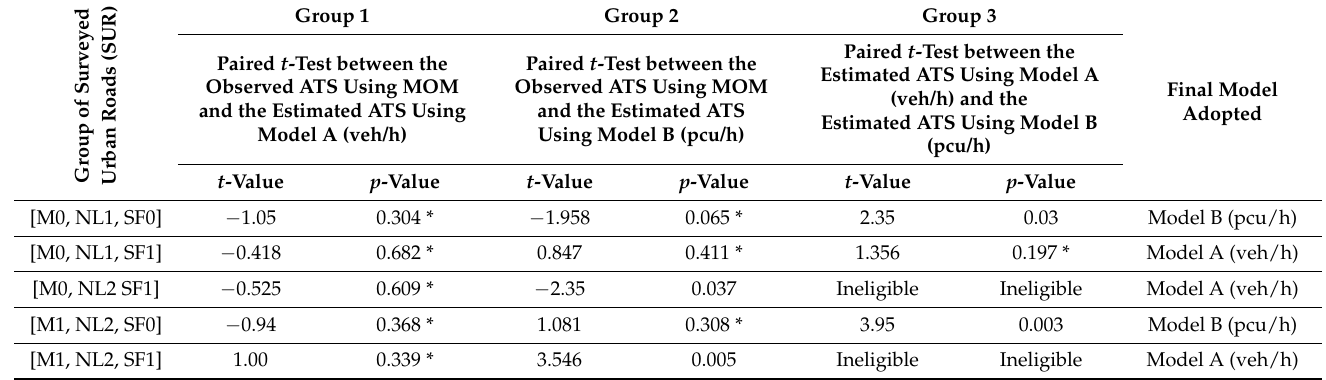
Table 6. Summary of models’ validation results for the five successful models based on the paired t